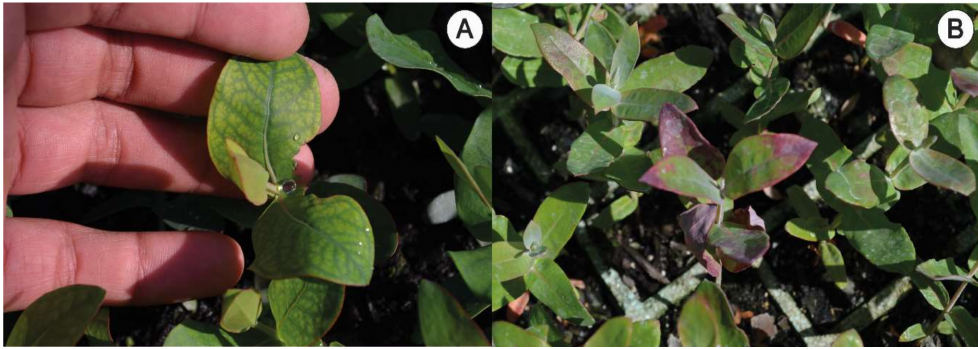
Figure 2. Deficiency symptoms of magnesium in Eucalyptus nitens ( A ) and phosphorus in